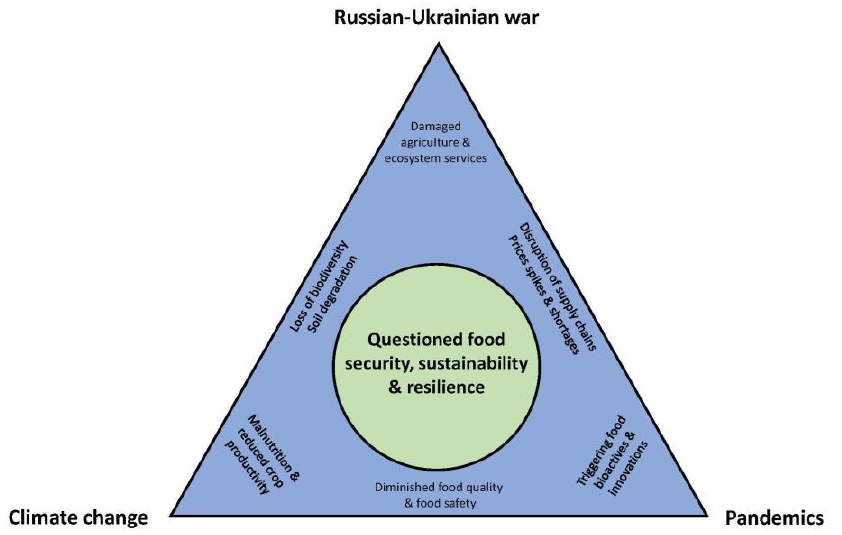
Figure 1. The impacts of climate change, pandemics, and Russian-Ukrainian war on the food sector.